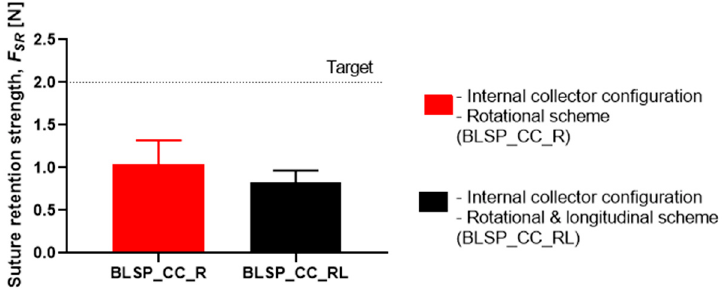
Figure 19. Suture retention strength. (A Student’s t-test was performed to determine any statistically significant differences between experiments. All tests were carried out at a 95% confidence interval and the results did not show statistically significant differences.)